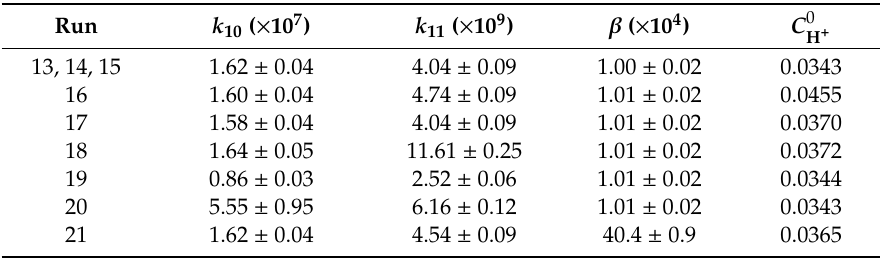
Table 5. Kinetic parameters and initial protonic concentration used for simulating the runs performed in the presence of phosphoric